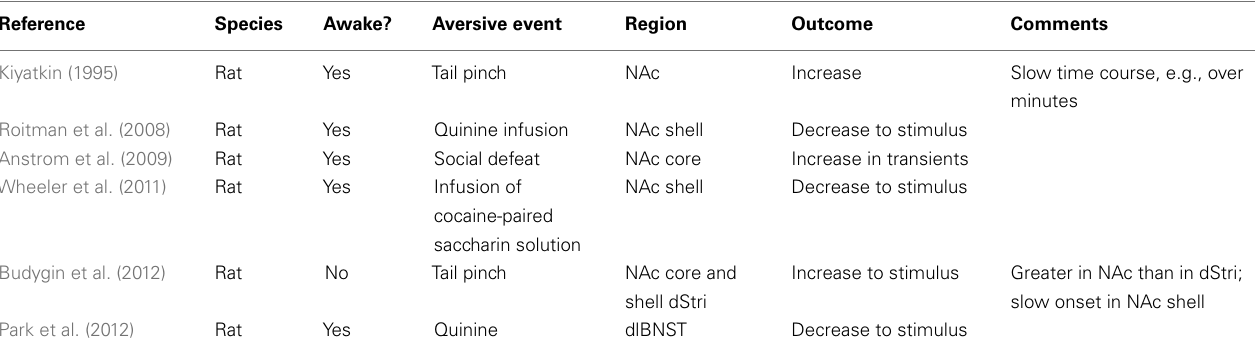
Table 2 | Phasic dopamine responses to aversive